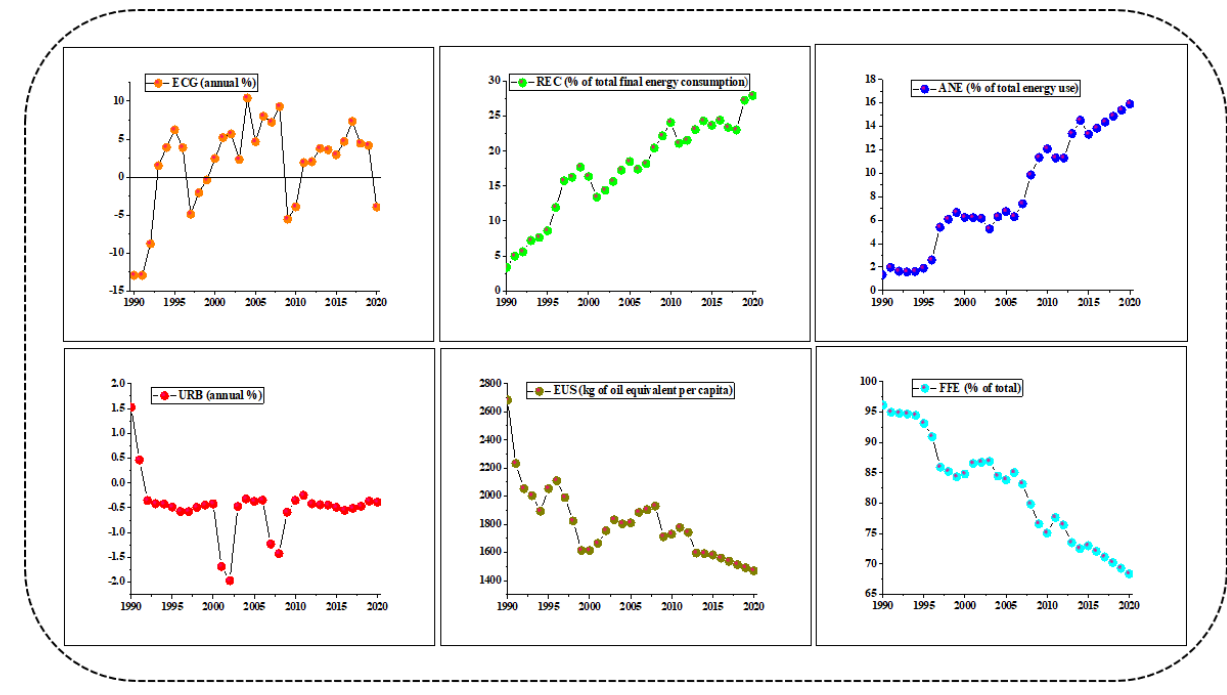
Figure 2. Time series trend of the variables.